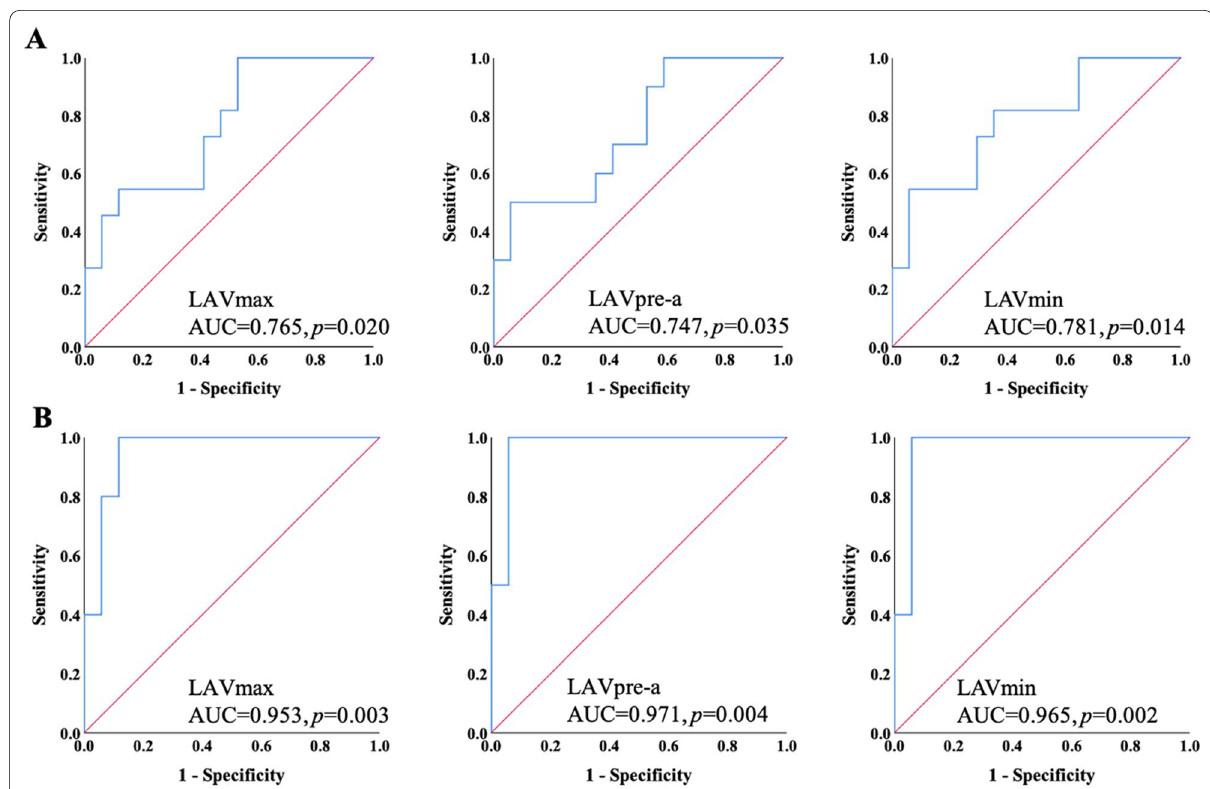
Fig. 4 Receiver operating characteristic curve analysis for discriminating patients with positive genotype ( a ) and multiple genetic mutations ( b ). AUC area under the curve, LAVmax maximal left atrial volume, LAVpre-a left atrial volume before LA contraction, LAVmin minimal left atrial